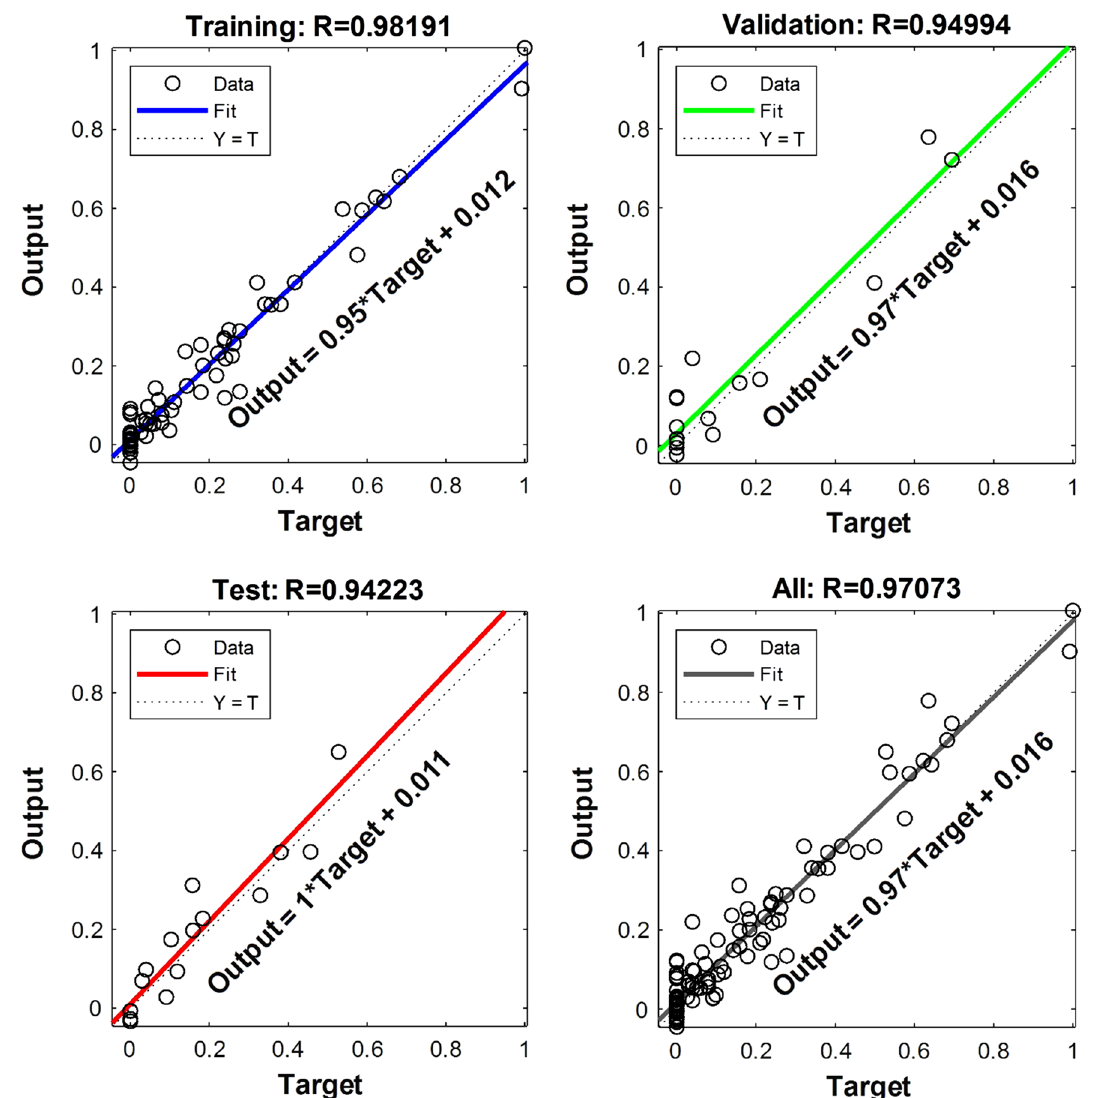
Fig. 25 The training regression of Model No.4 (ANN 4) for liquefaction